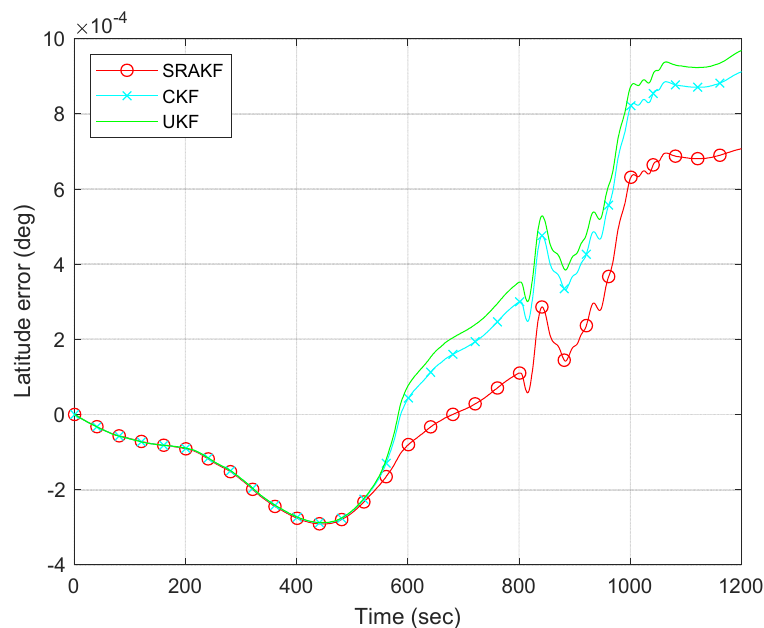
Figure 9. Latitude errors for the surface lake trial.